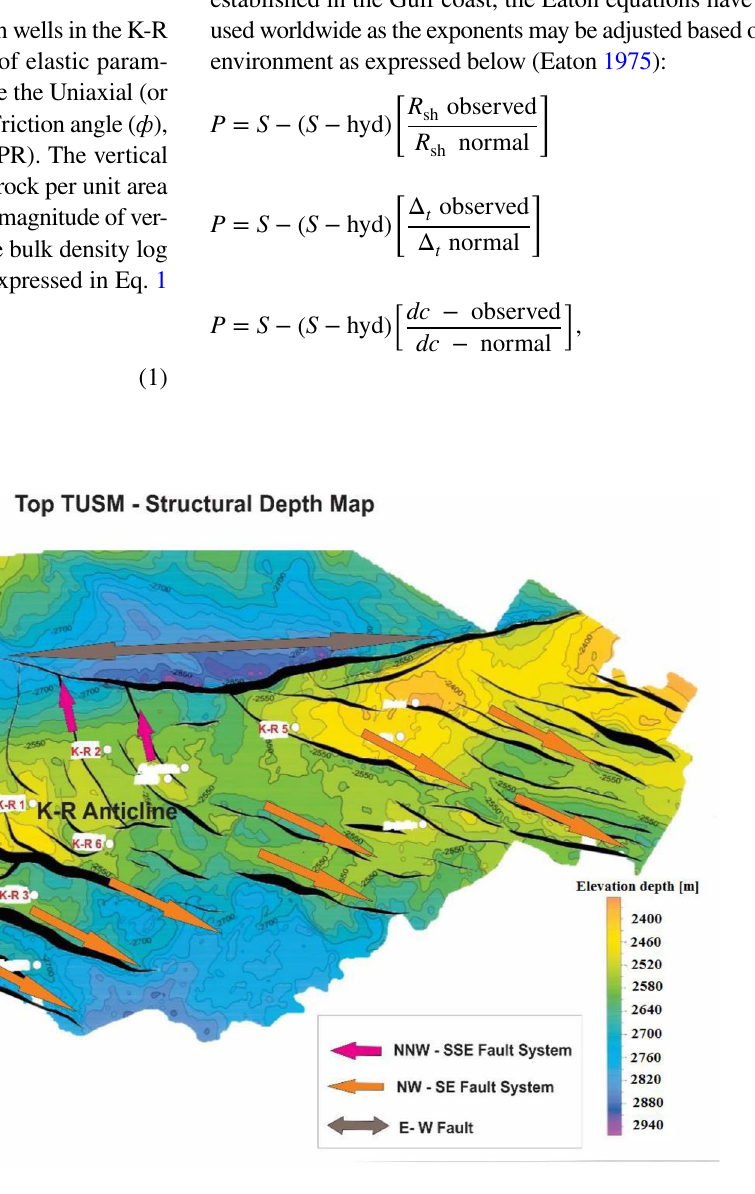
Fig. 3 A structural depth map showing the fault system of the KR-Anticline at